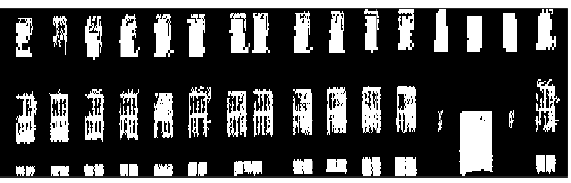
Figure 11. implementing erosion and dilation operations on figure 9